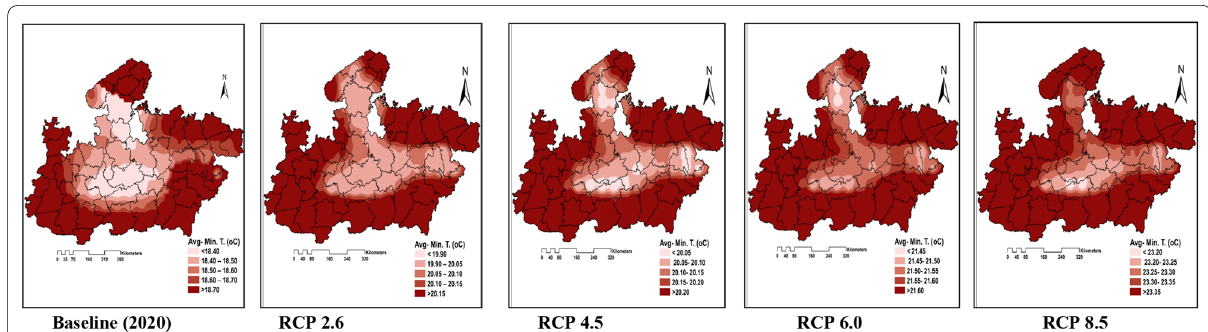
Fig. 10 Predicted change in the minimum temperature relative to baseline over the whole Madhya Pradesh state under different RCP scenarios of 2080. Under all the RCP scenarios, the average minimum temperature is projected to increase